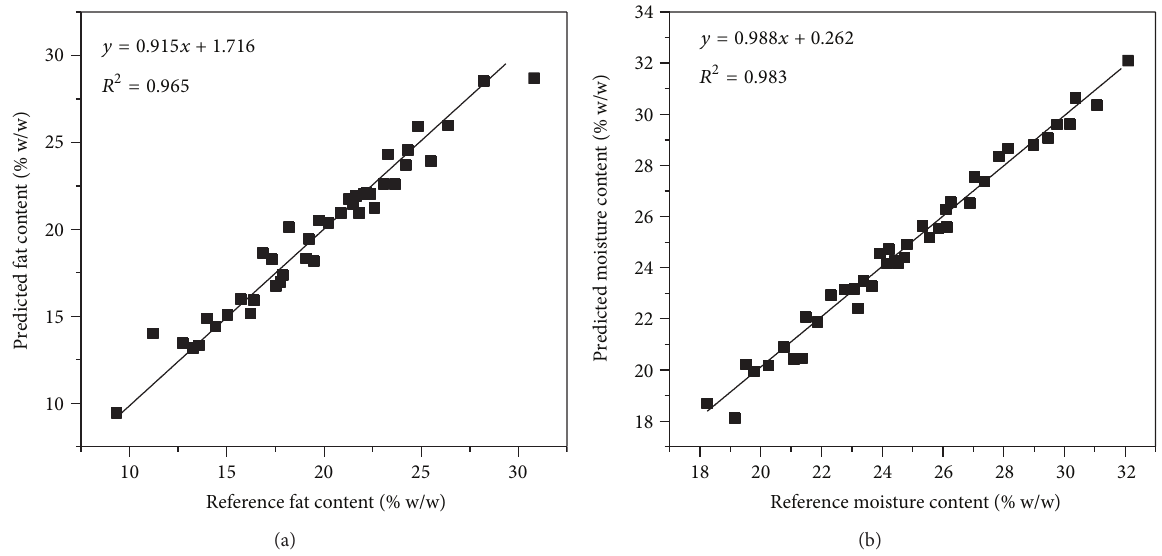
Figure 5: Plots of (a) fat and (b) moisture content predicted with PLS models versus their values determined with the standard method.